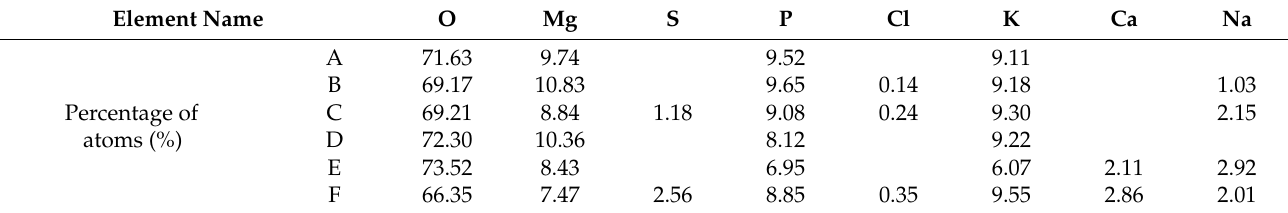
Table 3. Distribution of elements in the region of MKPC mortar